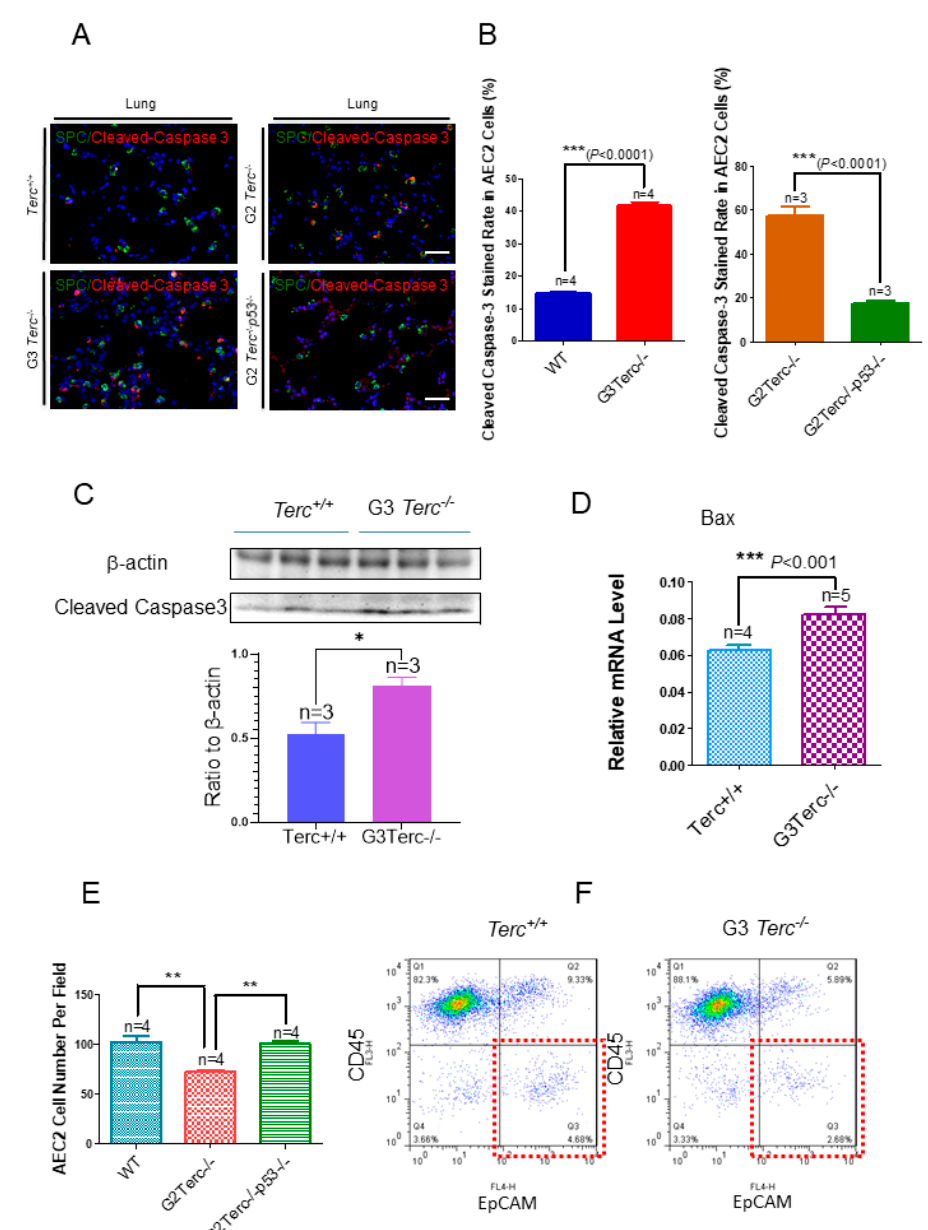
Figure 4. Marked increases in apoptosis-related cleaved caspase-3 staining rates in the AEC2 cells from late-generation Terc − / − mouse lungs and rescued in p53 − / − . ( A ). Representative double immunofluorescence staining of WT, G3 Terc − / − , G2 Terc − / − , and G2 Terc − / − p53 − / − mouse lungs (magnification: 40 × ) for SPC and cleaved caspase-3. Scale bar = 30 µ m. ( B ). Quantification of cleaved caspase-3 stained AEC2 cells by cell counting (as in ( A )). Data are mean ± SE values based on the indicated number of lungs. ( C ). Marked increases in apoptosis with cleaved caspase-3 in the late- generation Terc − / − mouse lungs by Western blotting analysis. ( D ). Increases in apoptosis-related Bax mRNA levels in the late-generation Terc − / − mouse lungs by RT-qPCR analysis. Data are mean ± SE values based on the indicated number of lungs. ( E ). Significant decrease in the AEC2 cell number by cell counting in the slides from late-generation Terc − / − mouse lungs, and rescued in p53 − / − . Data are mean ± SE values based on the indicated number of lungs. ( F ). Representative flow cytometry result showing significant decreases in AEC2 cell number (gated by CD45 − EpCAM + ) in late-generation Terc − / − mouse lungs. Statistical significance is indicated by * p < 0.05, ** p < 0.01, *** p <